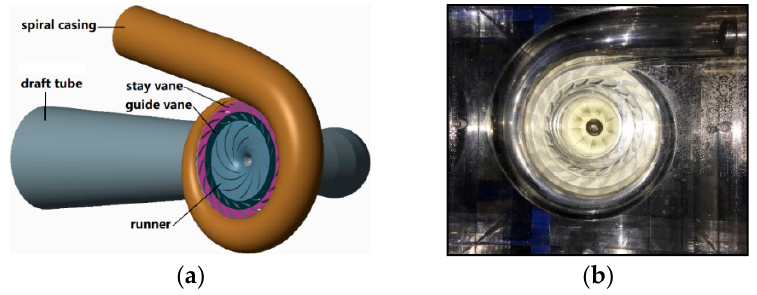
Figure 1. Geometry of pump turbine model. ( a ) 3D model of test pump turbine; ( b ) Test pump turbine.